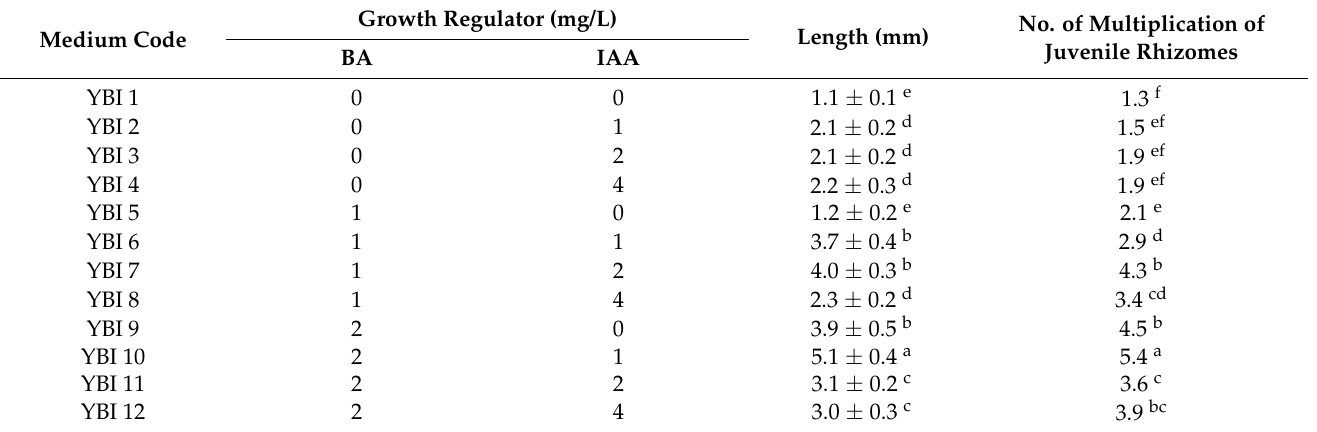
Table 2. Effect of BA and IAA concentration on growth and proliferation of G. elata juvenile rhizomes in the culture medium for 8